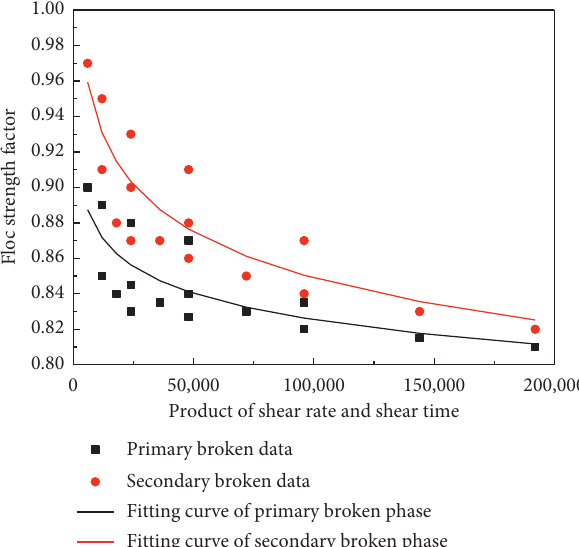
Figure 10: The variation of floc strength factor with the product of shear rate and shear time in the primary and secondary broken phases.